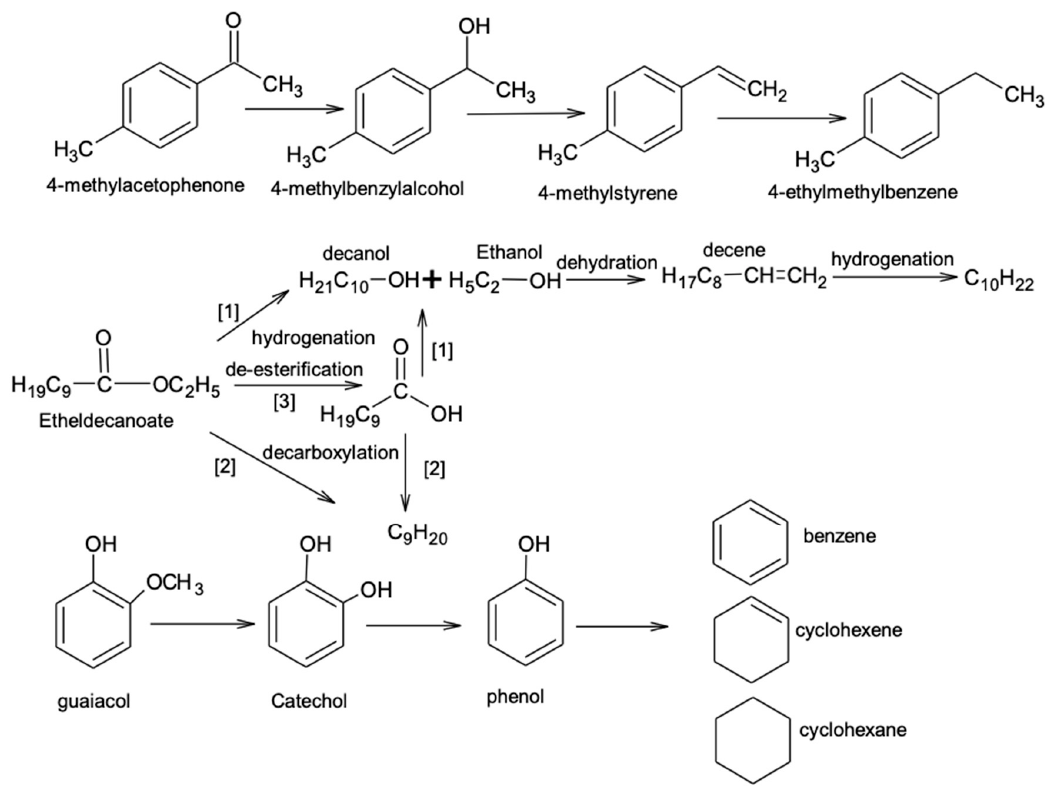
Figure 6. Hydrodeoxygenation of 4-methyl acetophenone, ethyl decanoate, and guaiacol. Reproduced from reference [63].